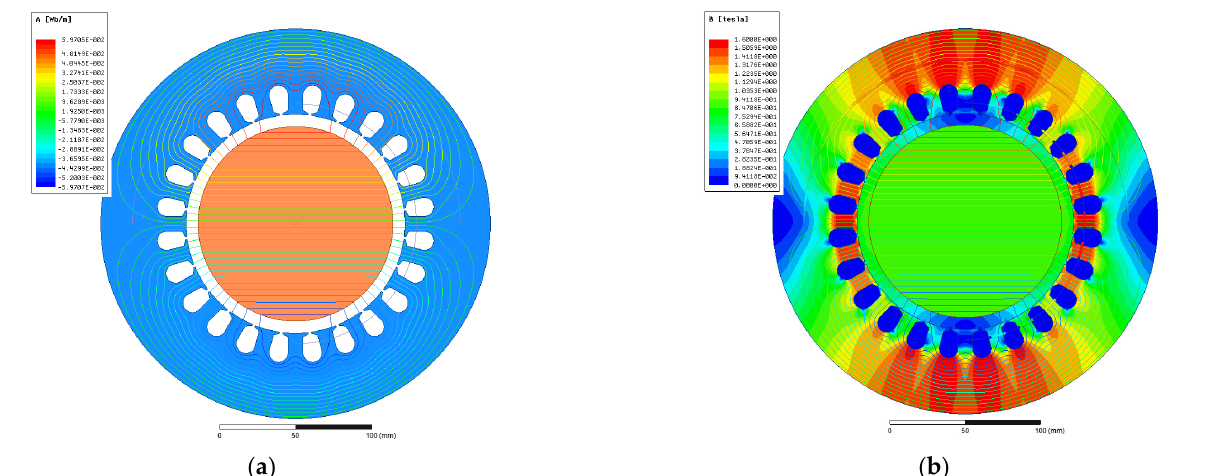
Figure 3. Stator magnetic flux distribution under no load: ( a ) The magnetic flux line distribution. ( b ) The magnetic flux density distribution.